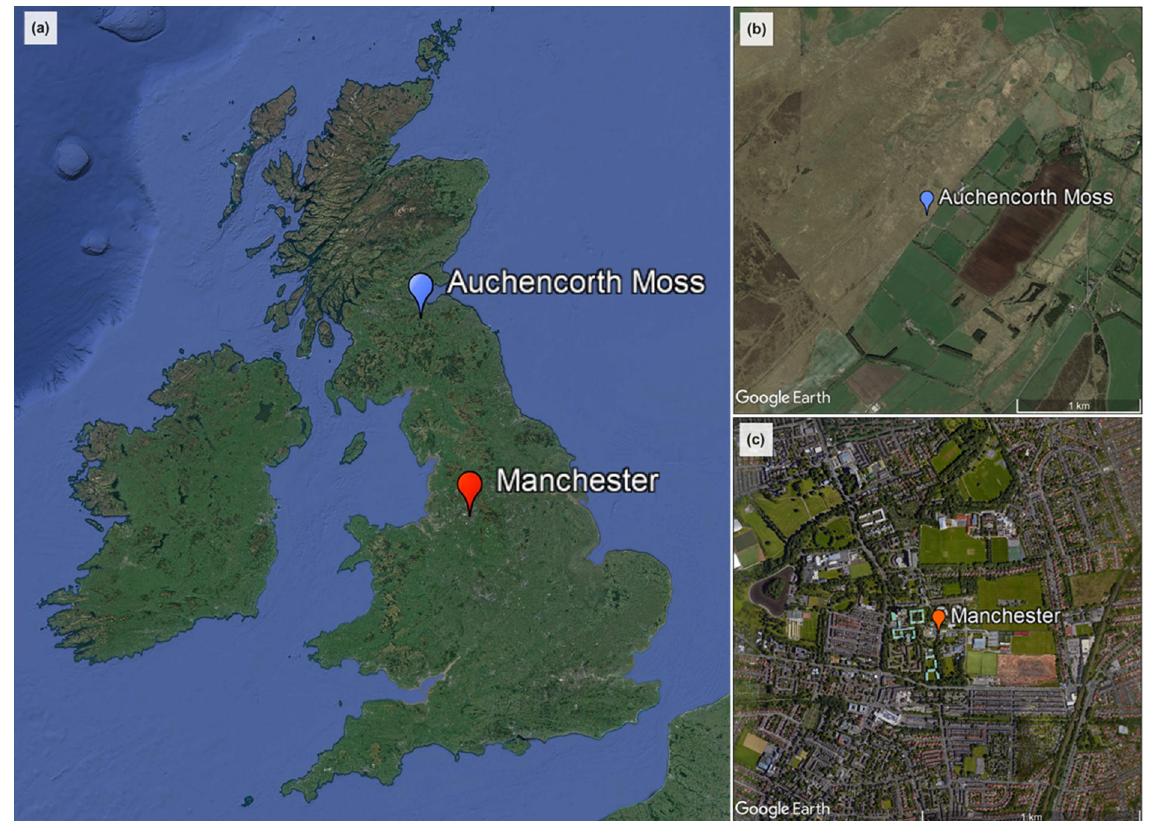
Figure 1. ( a ) The locations in the UK of the Auchencorth Moss rural supersite and Manchester urban background supersite; ( b , c ) respectively show satellite images of the area surrounding each measurement site to ~1 km in all directions. Satellite imagery from Google Earth (2021).